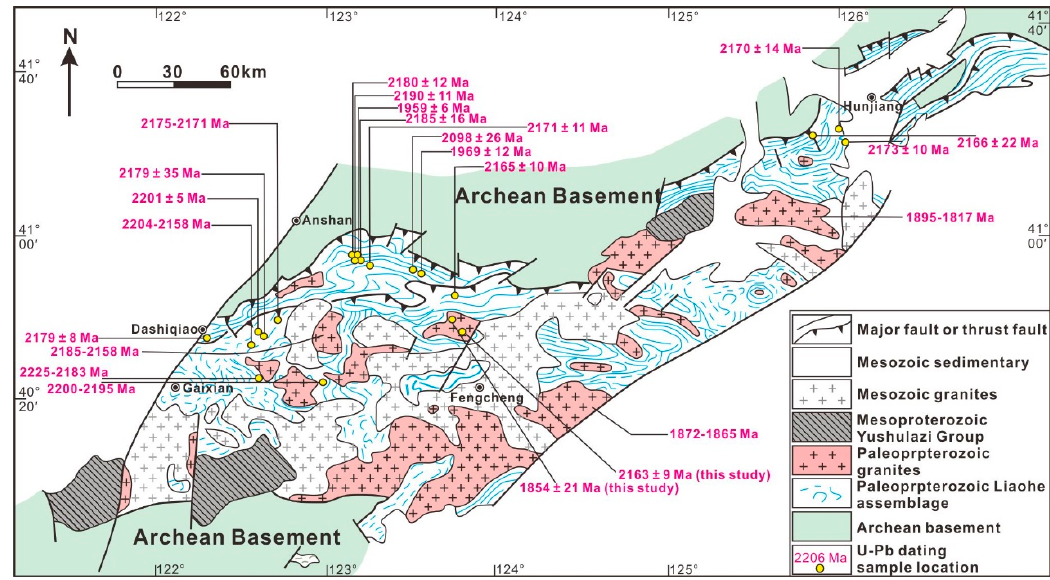
Figure 9. Geological sketch and age distribution of the northeastern Jiao-Liao-Ji Belt (modified after Bi et al. [34] and Dong et al. [35]). Note: the age data in the figure are listed in Supplementary Table S4.